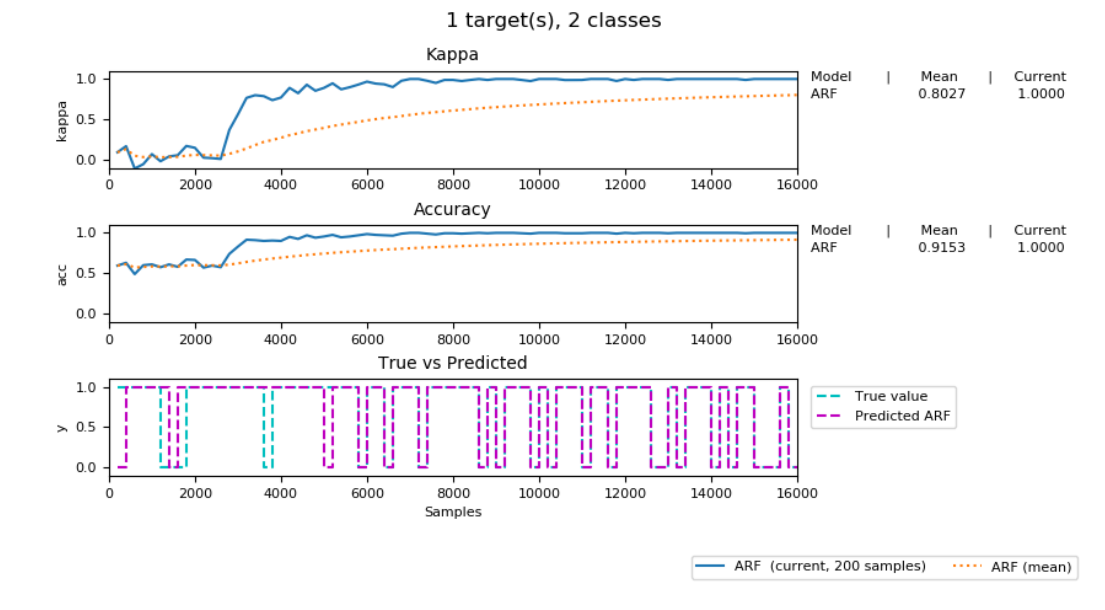
Figure 17. Incremental predictive learning